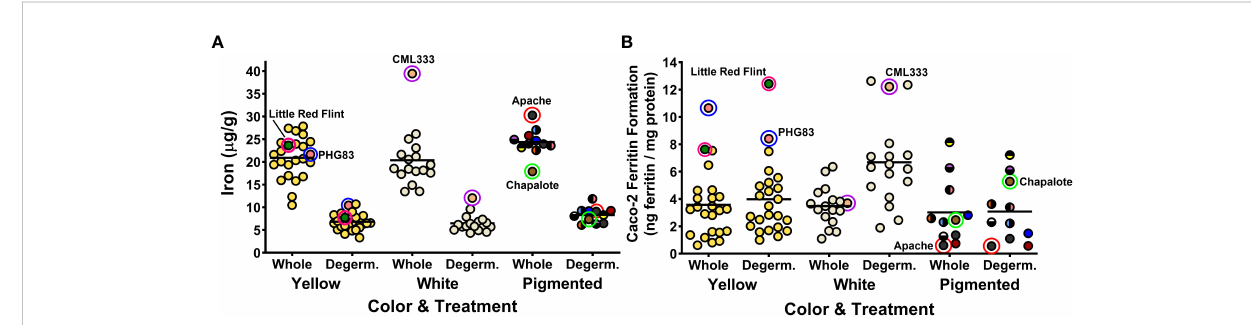
concentrations are measured as micrograms per gram of cooked, lyophilized and milled maize sample (dry weight). Iron bioavailability is measured as Caco2 cell ferritin concentrations (ng ferritin/mg total cell protein) after exposure to an in vitro digestion of cooked, lyophilized and milled maize sample. Highlighted circles indicate examples of genotypes with unique iron bioavailability traits after degermination. The circle color of pigmented maize represents the bran color pattern of each